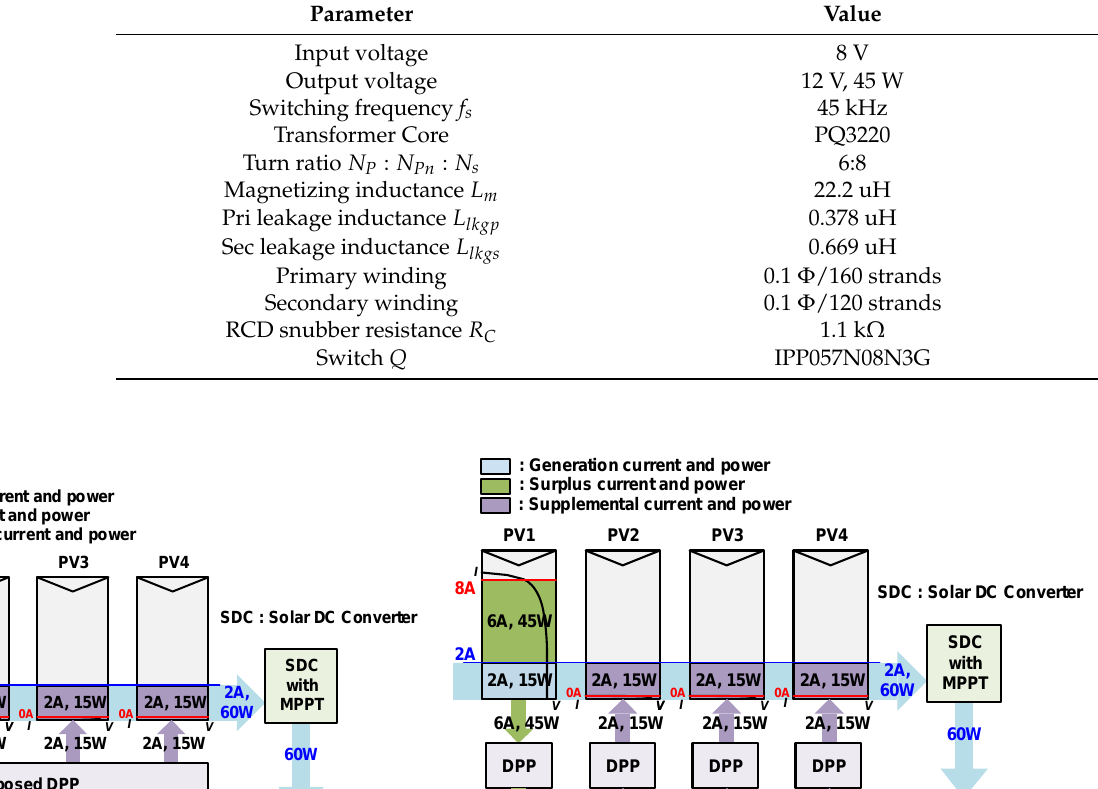
Table 4. Conventional flyback DPP converter parameters.